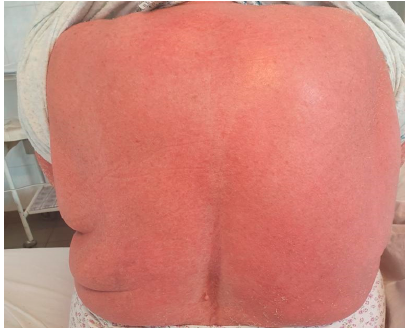
Figure 4. Erythematous skin rash with lamellar desquamation.